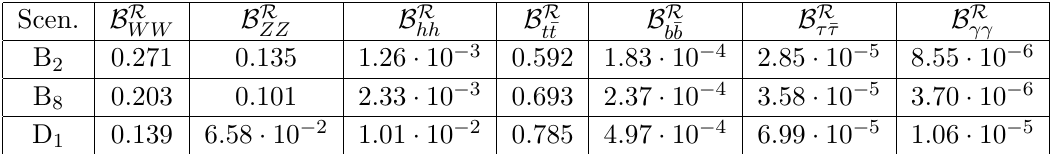
Table 5 . The radion branching fractions in the scenarios B 2 , B 8 and D 1 . Scen. B (predic.) 2